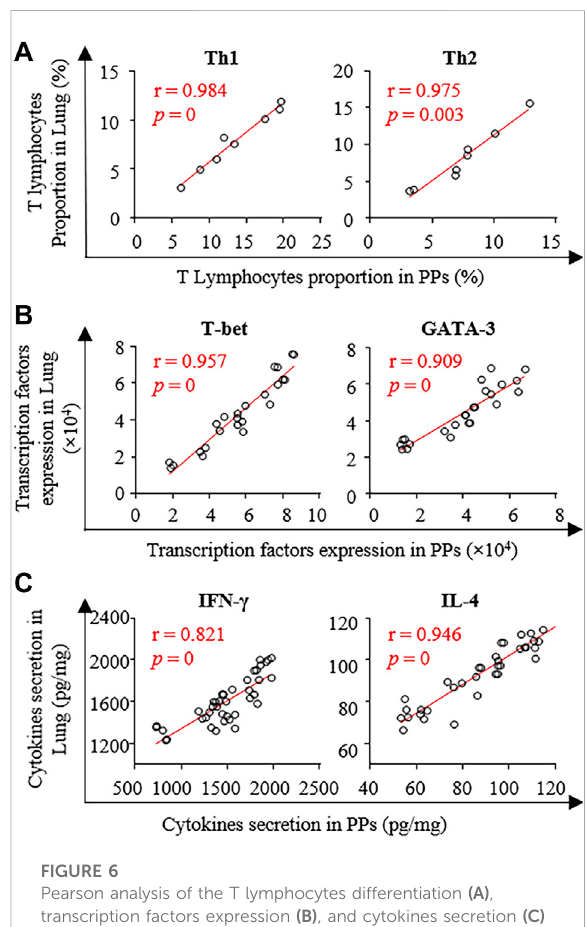
FIGURE 6 Pearson analysis of the T lymphocytes differentiation (A) , transcription factors expression (B) , and cytokines secretion (C) between PPs and